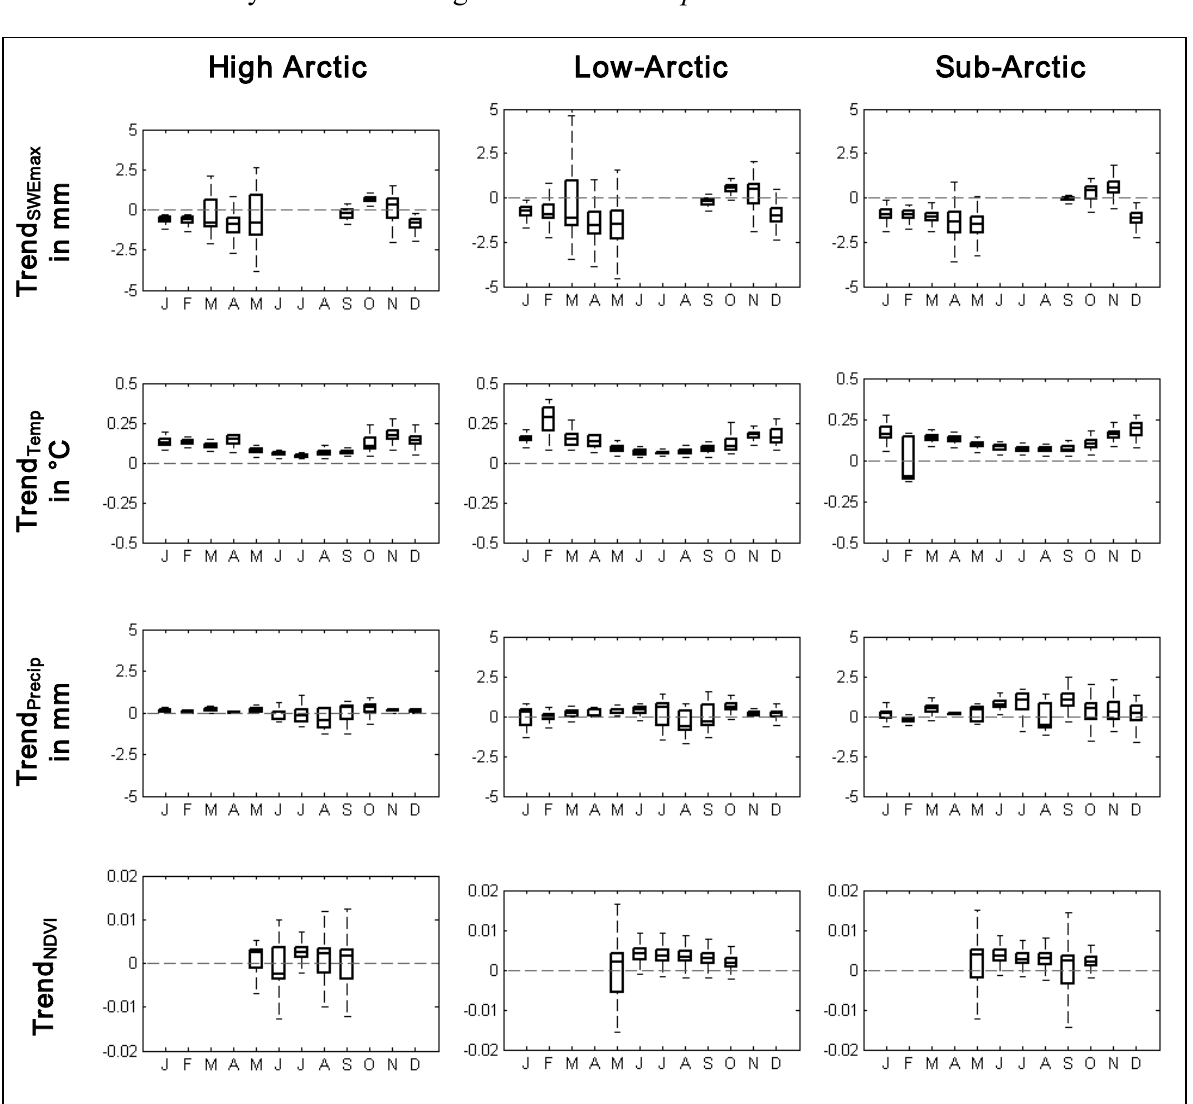
Figure 5. Monthly inter-annual variability of the slopes from the multivariate trend calculations. Only trends with a significance level of p < 0.05 are